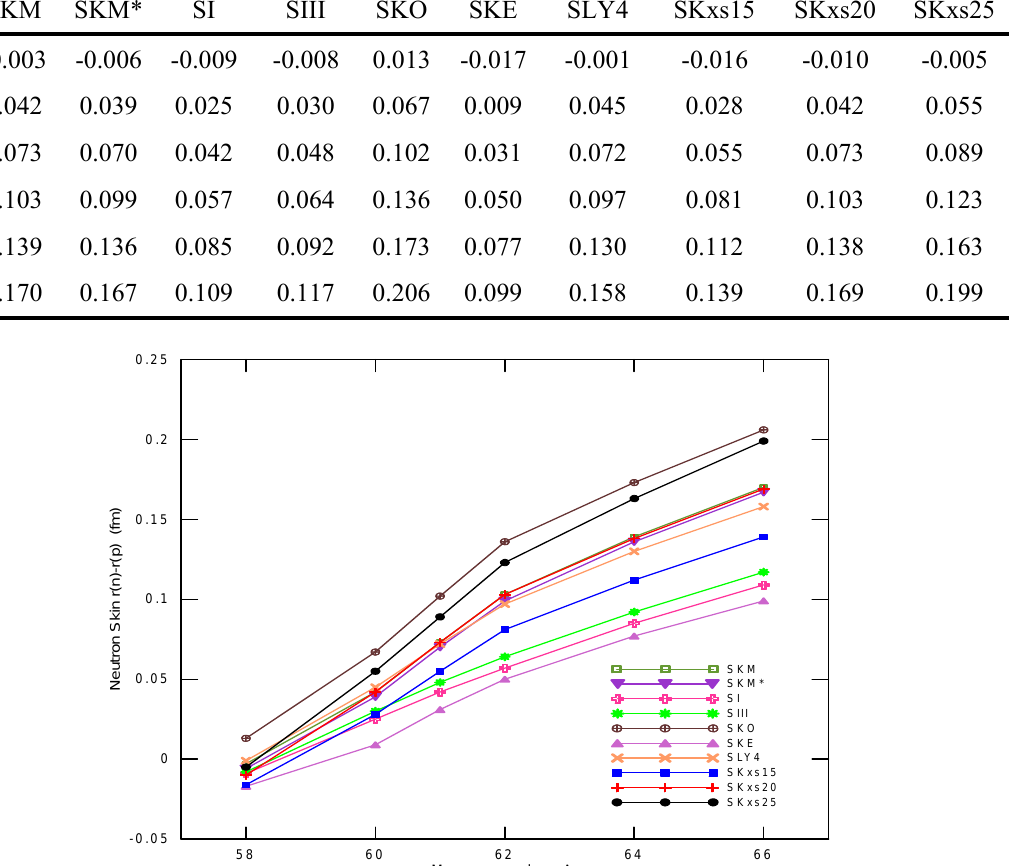
Table 7: Calculated neutron skin thickness (fm) for the selected Ni-isotopes.